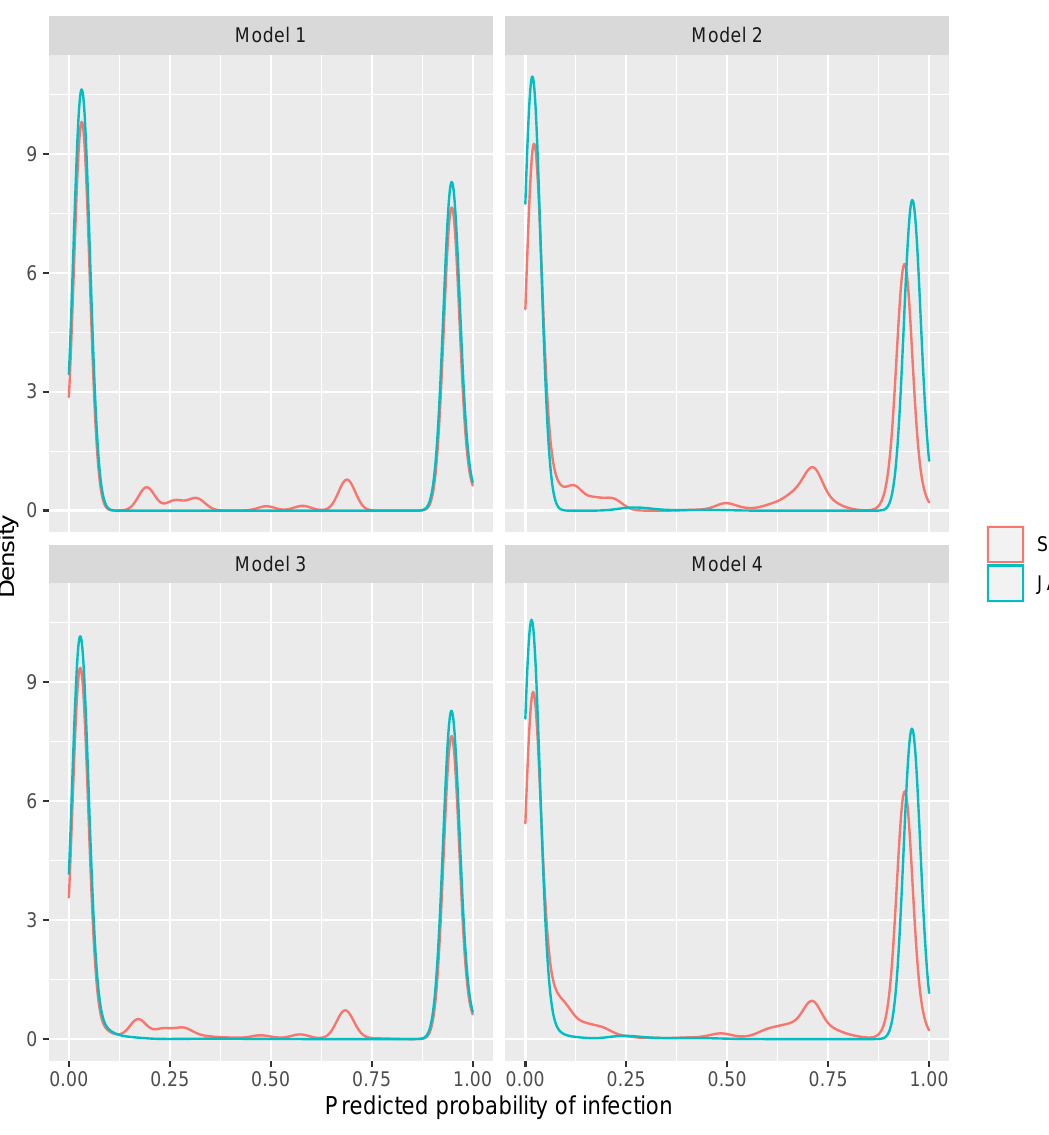
Figure 8 – Distributions of predicted probabilities of being status positive for all herds with the 4 Bayesian models evaluated with Stan and JAGS. Model 1: Perfect test, no risk factor; Model 2: Imperfect test, no risk factor; Model 3: Perfect test, risk factor; Model 4: Imperfect test, risk